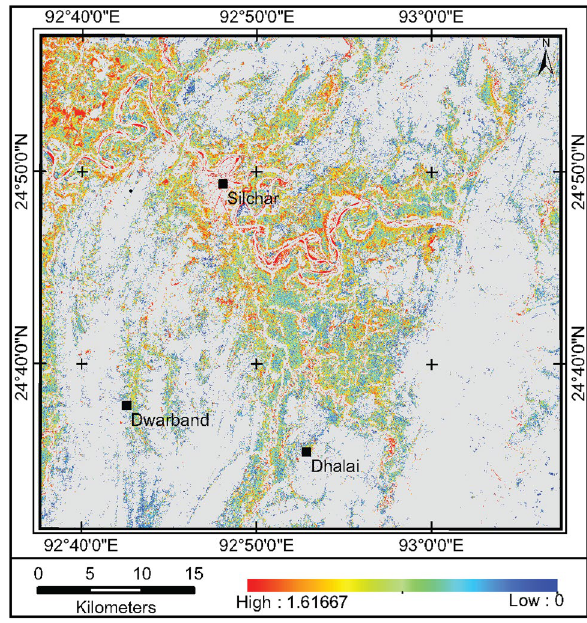
Fig. 7 Band ratio image 3/1 showing ferric iron (Fe 3+ )-poor areas as low pixel values (shades of lighter gray regions are areas of thick veg- etation/water bodies)